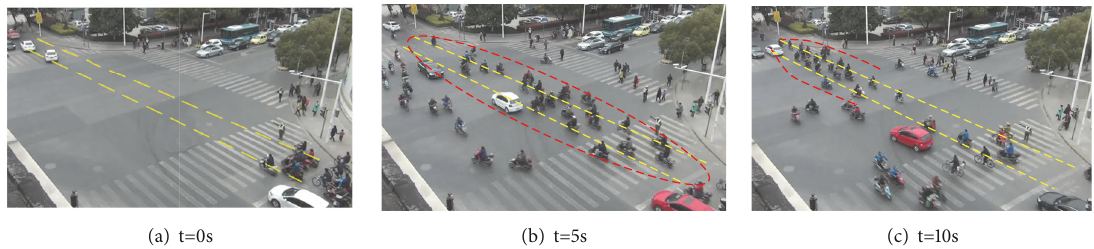
Figure 1: Dispersion phenomenon at a mixed flow